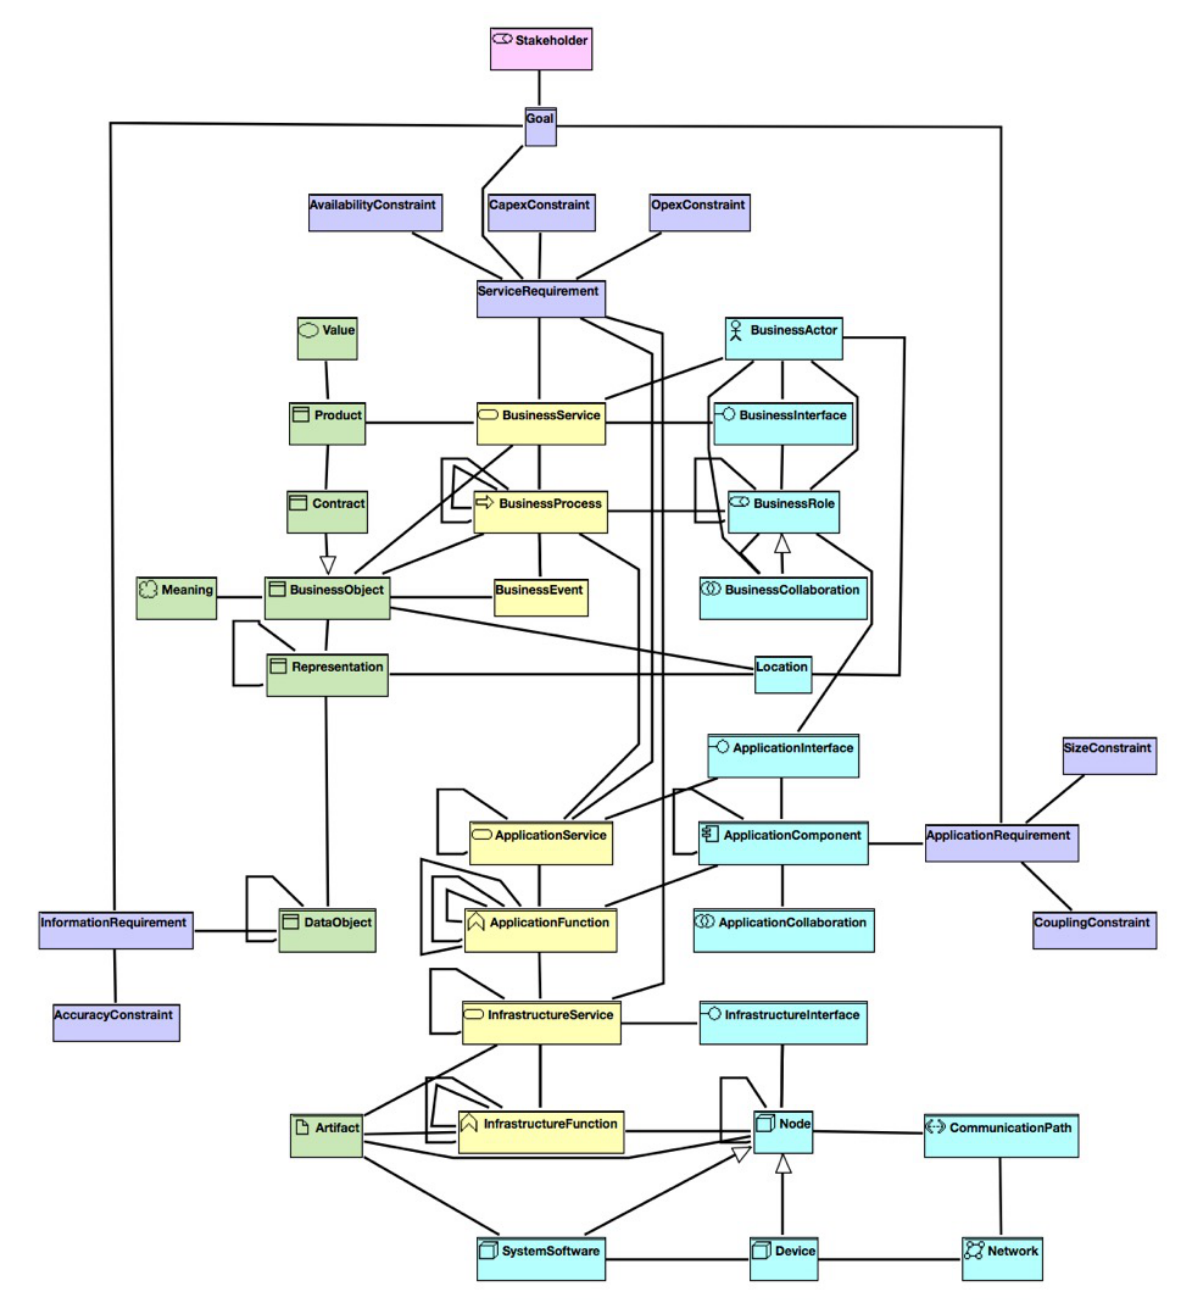
Figure 1. An overview of the classes and relations in MAPL. Attributes have been omitted for